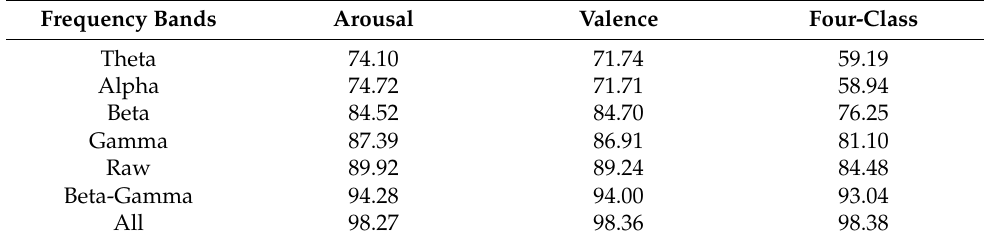
Table 2. Classification accuracies on each frequency band and their combination.